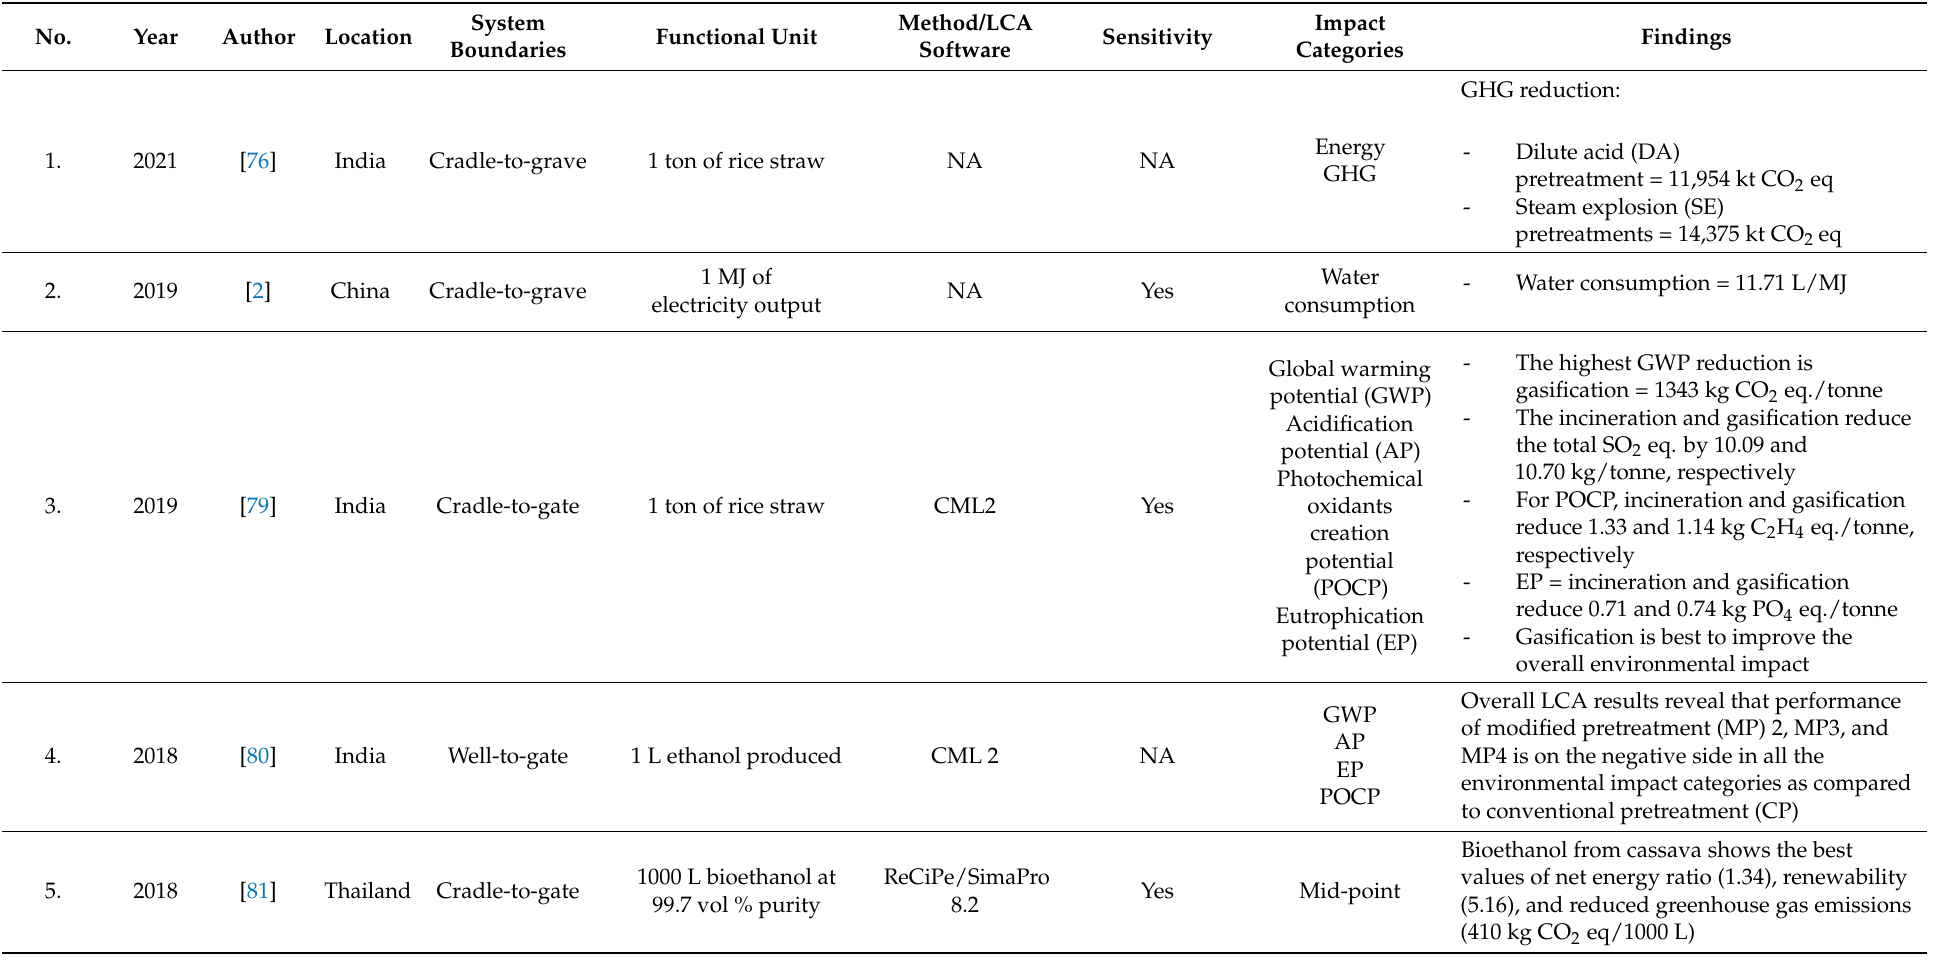
Table 3. Previous studies of LCA of rice straw utilisation for